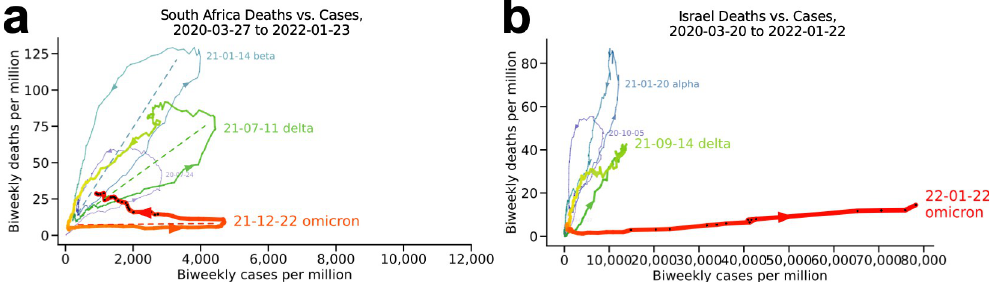
Fig 1. South Africa and Israel. All plots are colored by wave. Waves are labeled by variant if a single known variant predominated. Date labels appear at the peak cases-per-million for each wave. Arrowheads indicate the flow of time. Dotted lines in (a) are guides to the eye regarding the orientation of the loops, indicating the progressive flattening of the last three